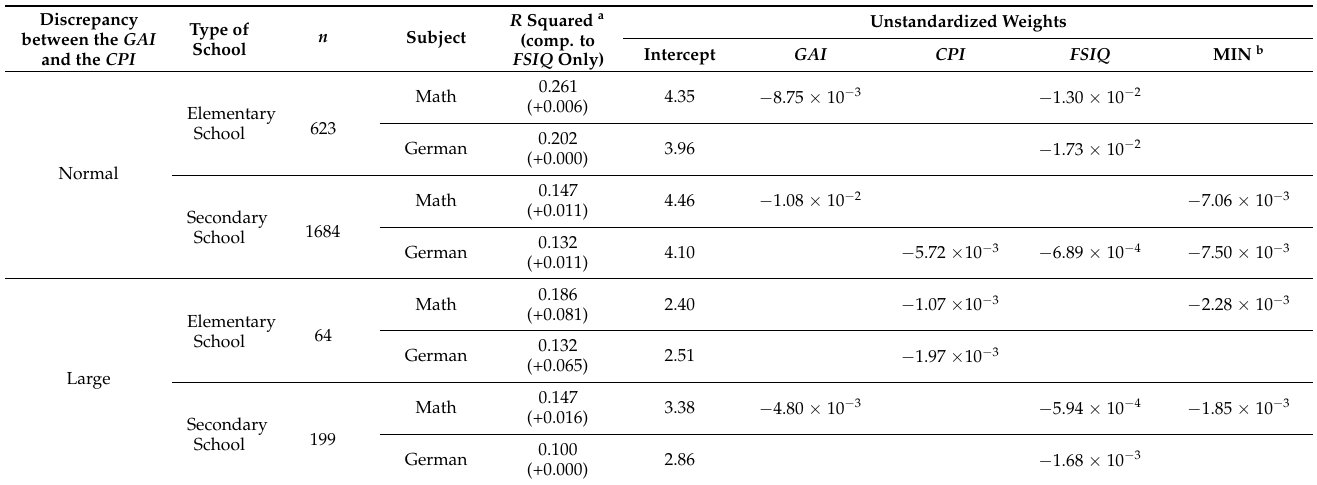
Table 3. Regression models to predict grades in German and mathematics from the GAI , the CPI , the FSIQ , and the minimum out of these three